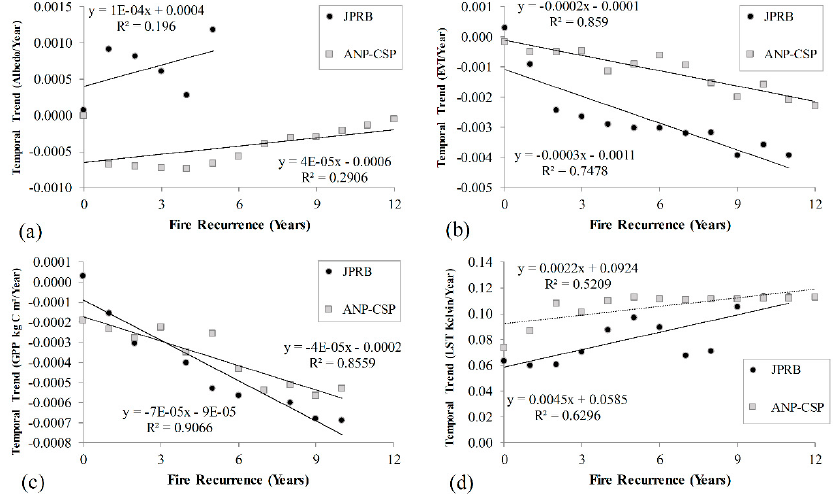
Figure 9. Fire recurrence relationship in the Ji-Paran á River Basin (JPRB) and Araguaia National Park / Cant ã o State Park (ANP-CSP) areas with ( a ) Albedo, ( b ) Enhanced Vegetation Index (EVI), ( c ) Gross Primary Productivity (GPP), and ( d ) Land-Surface Temperature